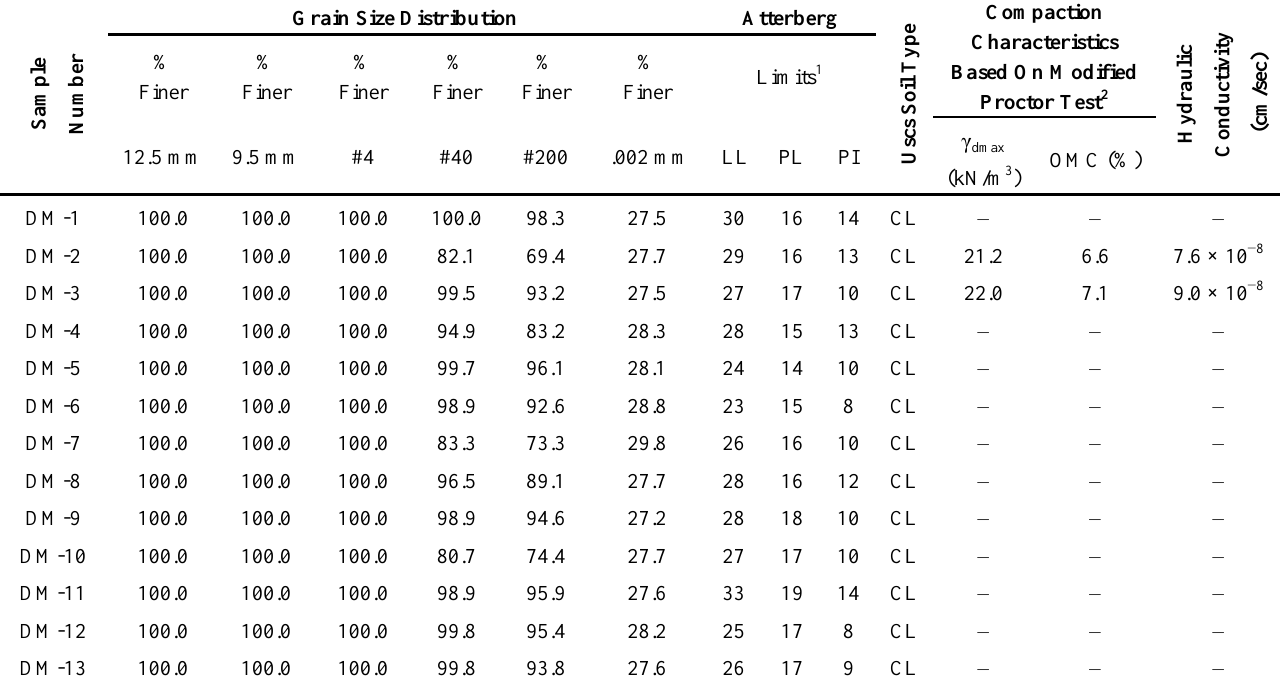
Table 1. Geotechnical characteristics of DM-samples selected for further